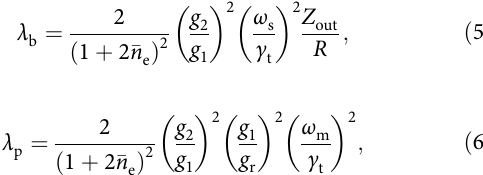
Fig. 2 Sketch of the experimental outcome. Distribution of outcomes V M for two different phonon numbers: n b = 0 ( fi rst peak to the left) and n b = 1 (last peak to the right). For a given value of n b , repeated measurements are Gaussian distributed with a variance σ 2 / 1 þ 2 (cid:2) n consisting of vacuum and thermal noise. The distance d between the two peaks depends on the circuit parameters and the number of incident photons, and identi fi es the signal-to-noise ratio D = d / σ . Ideally, for each shot of the measurement, the mechanics is either in its ground or fi rst excited state. However, for Δ n b > 0 there will be events where the mechanical state jumps, resulting in outcomes V M in between the peaks relative to n b = 0 and n b = 1 (smaller peaks in the fi gure). This leads to the smeared distribution shown in the back. The visibility of the QND measurement is quanti fi ed by the values at the peaks and valleys, as indicated by I 0 , I 1 and I R (see Eq. (9)). The fi gure is for illustration only, and is not to